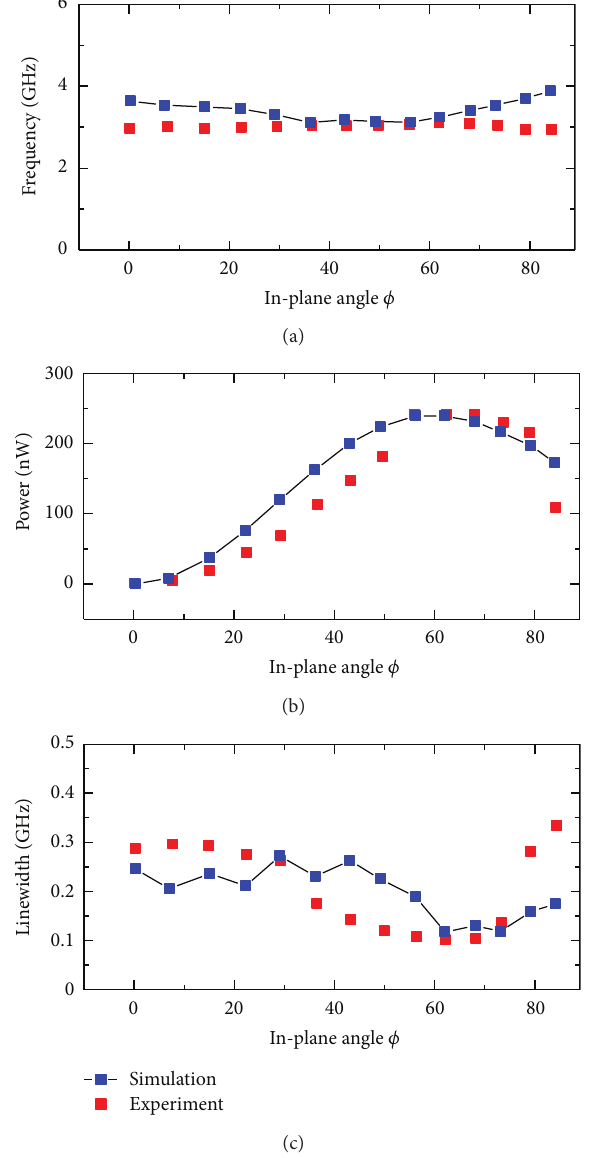
Figure 4: Comparison of simulation results for three characteristics ofSTOswithexperimentaldata[7]asfunctionsoftheperpendicular torque and the inplane angle 𝜙 . (a) Frequency, (b) mean power, and (c) linewidth.